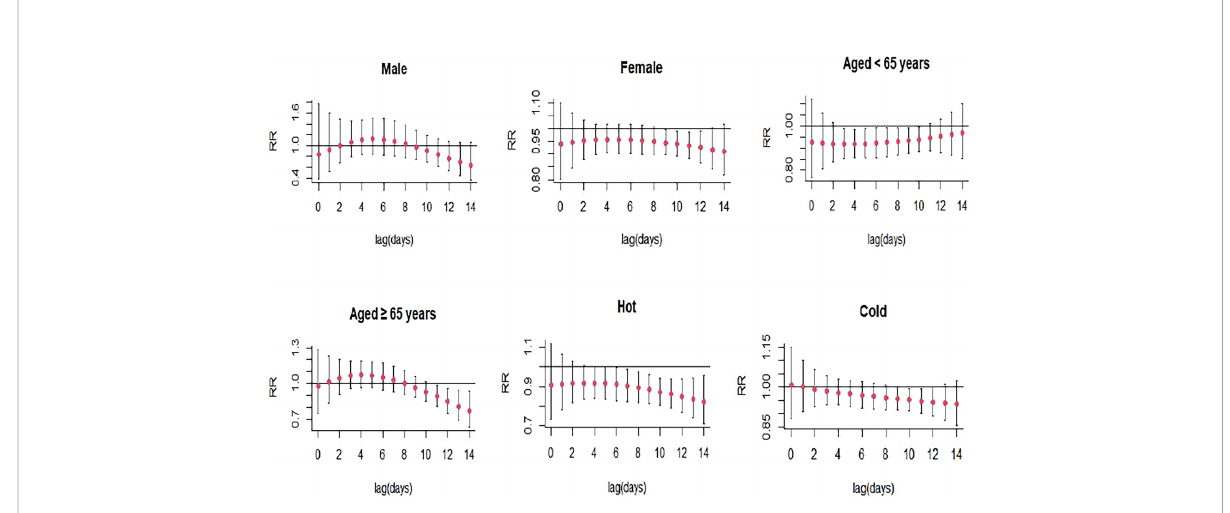
FIGURE 6 Lag-speci fi c relative risks (95% CI ) of SS hospitalizations per 10 unit increase in the daily concentrations of SO 2 in models strati fi ed by age, gender, and